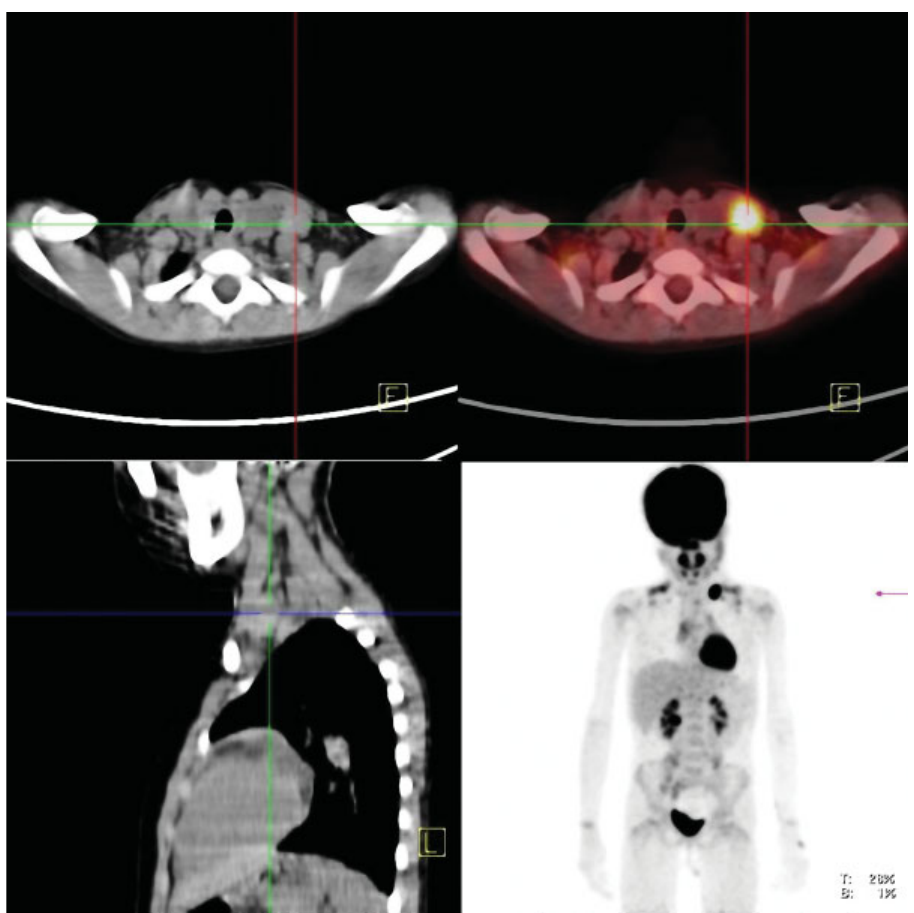
Fig. 1 Images showing a 2 (cid:1) 1.5 cm sized mass in the left supraclavicular region with increased metabolic activity (SUV max 9.09).